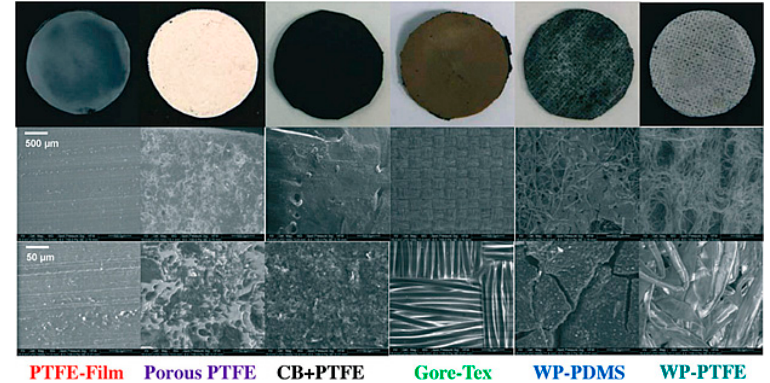
Figure 3. Digital photographs ( top row ) and scanning electron microscope (SEM) images ( bottom rows ) of different cathode diffusion layers. (Reproduced from [91] with permission of The Royal Society of Chemistry). PTFE: Polytetrafluoroethylene; WP: Wipe-based; PDMS: Polydimethylsiloxane.